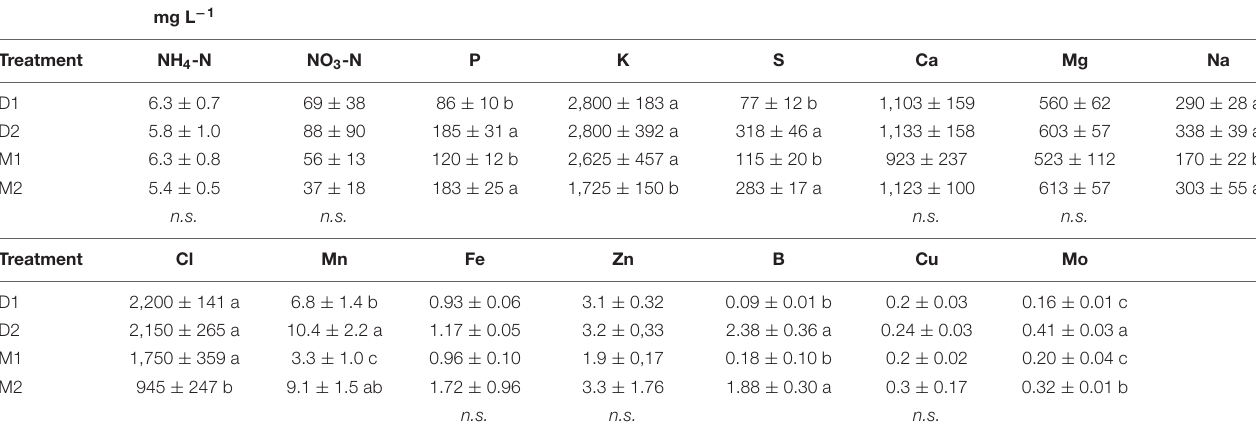
TABLE 6 | Concentrations (mg L − 1 ) of macro- and micro-nutrients in plant sap at harvest of pak choi grown in soilless system fertilized with anaerobic digestate (D1, D2) or mineral fertilizers (M1, M2). mg L − 1 Treatment NH 4